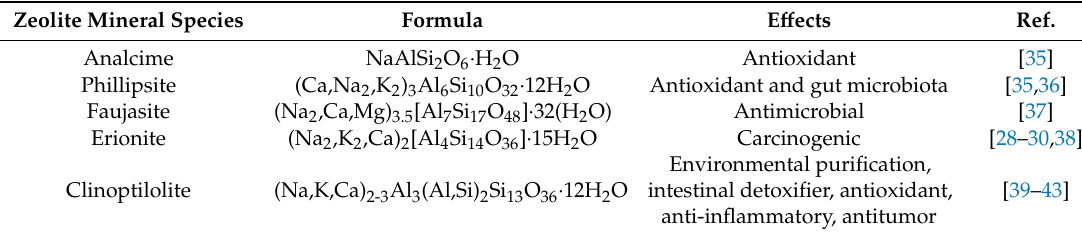
Table 1. Characteristics and biological e ff ects of some types of